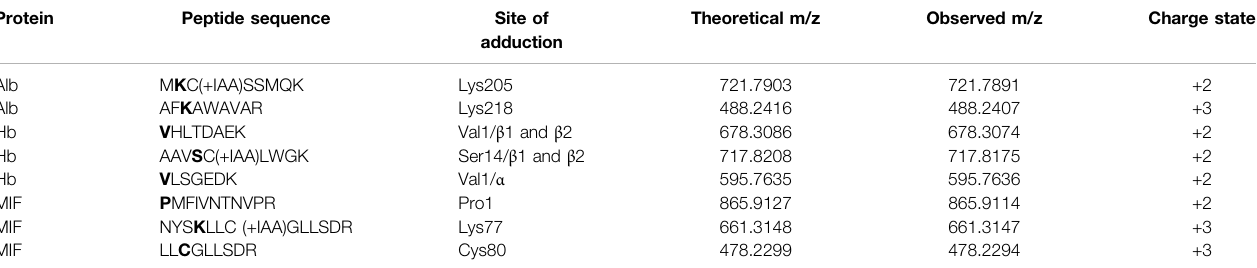
TABLE1| Con fi rmedmodi fi cationssitesinthedifferentproteinsafter invitro incubationsatdifferentTRITCtoproteinmolarratios.*boldlettersindicatethesiteofadduction. Protein Peptide